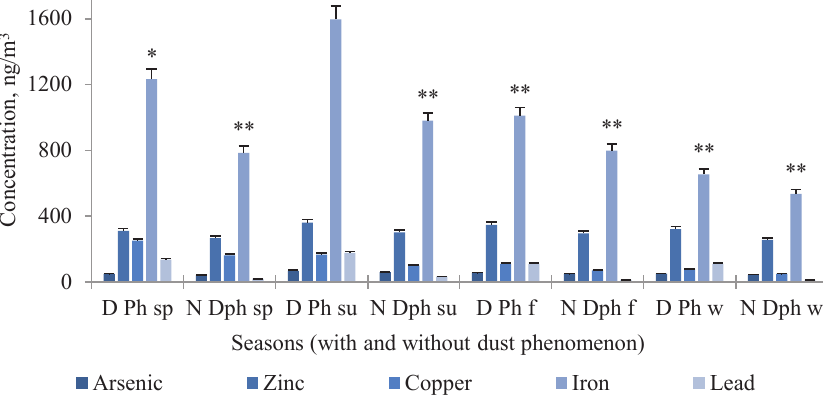
Figure 2 Seasonal average concentrations of heavy metals (lead, arsenic, zinc, copper, iron) in dust phenomena. Dust phenomenon in spring (D Ph sp), non-dust phenomenon in spring (N Dph sp), dust phenomenon in summer (D Ph su), non-dust phenomenon in summer (N Dph su), dust phenomenon in fall (D Ph f), non-dust phenomenon in fall (N Dph f), dust phenomenon in winter